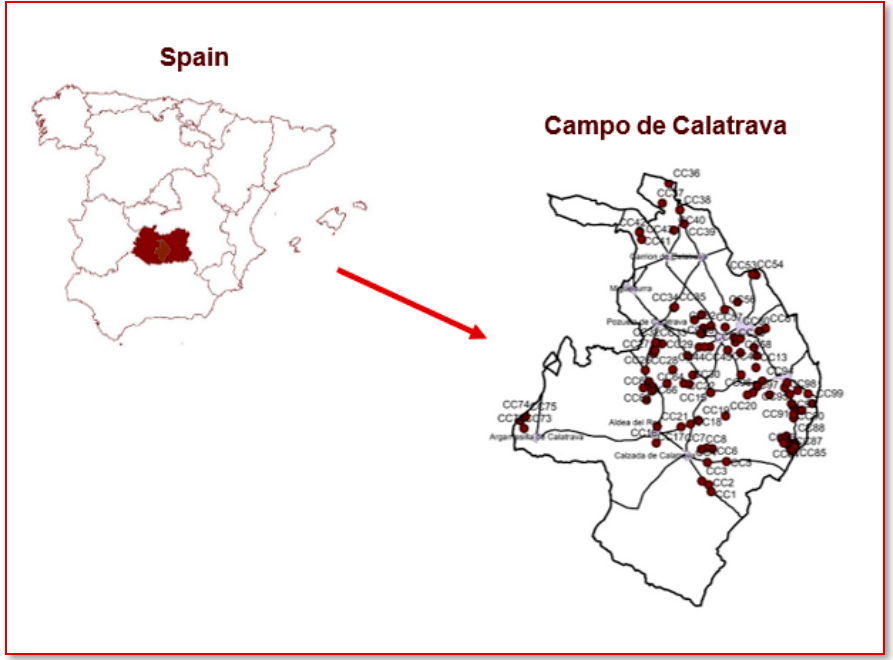
Figure 1. Location and map of the study area. Locations of sampling points (87 soil profiles).